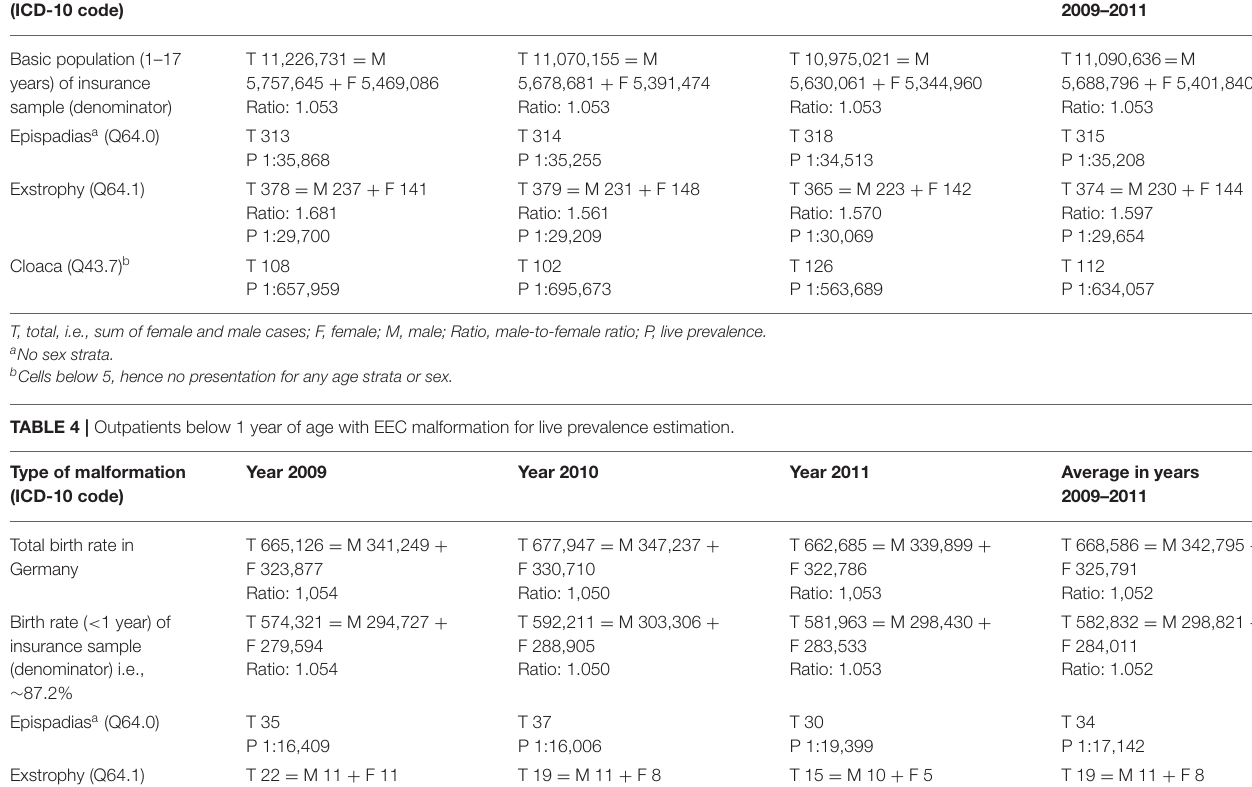
TABLE 3 | Outpatient data of children and adolescents 1–17 years of age with EEC. Type of malformation (ICD-10 code) Basic population (1–17 years) of insurance